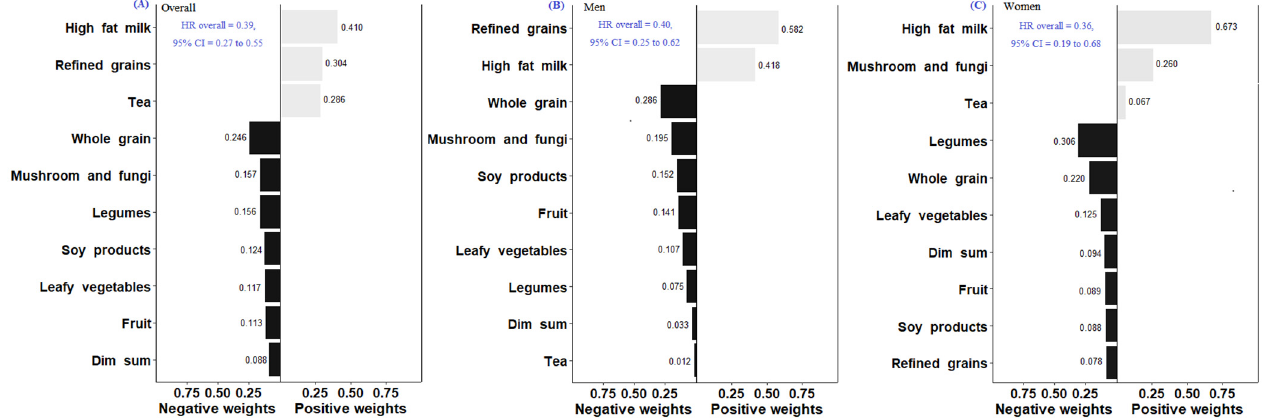
Figure 1. Weights representing the proportion of the positive or negative partial effects of each food group on all-mortality risk in the Quantile G-Computation Overall ( A ), Men ( B ), and Women ( C ). Model adjusted for sex, age, dietary energy, body mass index, physical activity, systolic blood pressure, medical history (diabetes, hypertension, stroke, heart attack, angina, congestive heart failure or cancer), smoking habits, alcohol drinking, and education